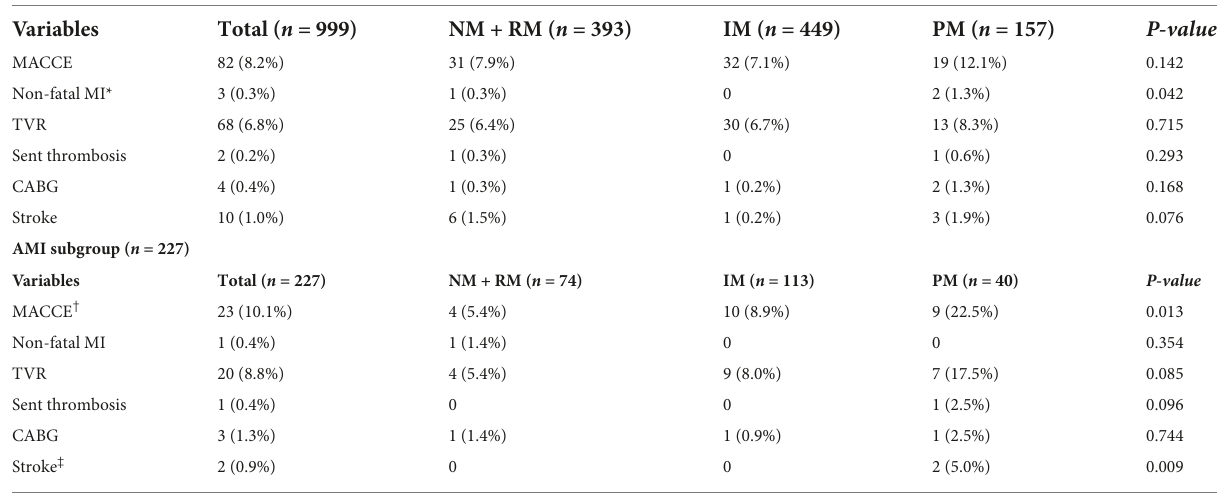
TABLE 4 Clinical outcomes of all participants and of the AMI subgroup.